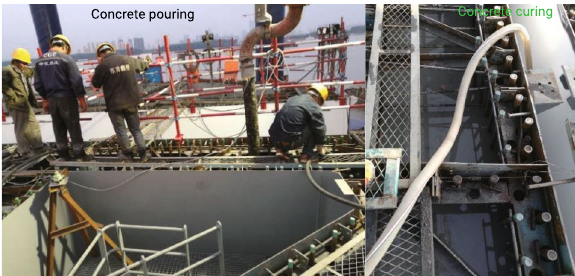
Figure 18. Concrete pouring and curing in steel shell.